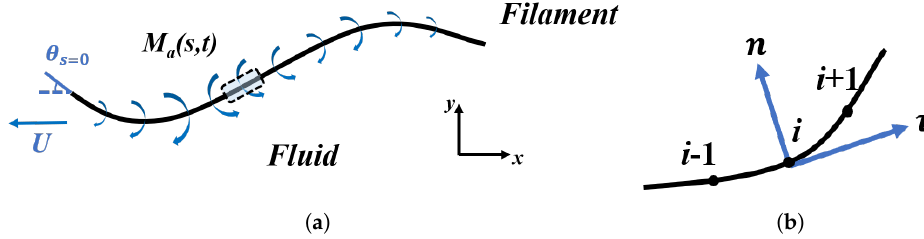
Figure 1. ( a ) Schematic diagram of the model problem. ( b ) Enlarged view of an isolated element corresponding the one represented by a dashed box in ( a